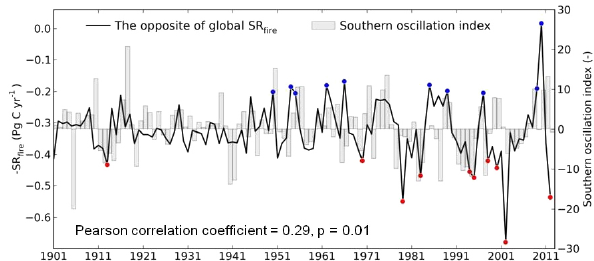
Figure 10. The fire-induced sink reduction (left vertical axis, − SR fire ) and its correlation with the Southern Oscillation Index (SOI, right vertical axis), which is an indicator of the El Niño South- ern Oscillation (ENSO) climate oscillation. The red dots indicate the 10 highest SR fire years and the blue dots indicate the 10 lowest SR fire years. Note that the left vertical axis shows the opposite of SR fire